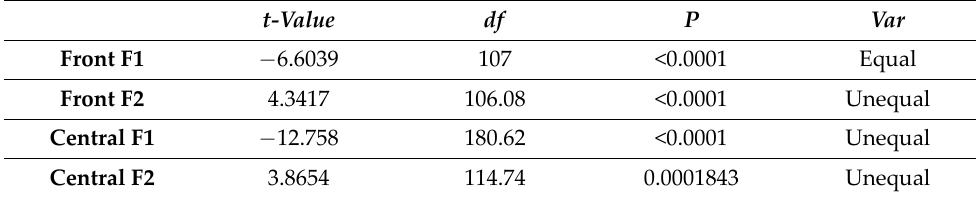
Table A2. Two‑sample t‑tests for lexical and HM